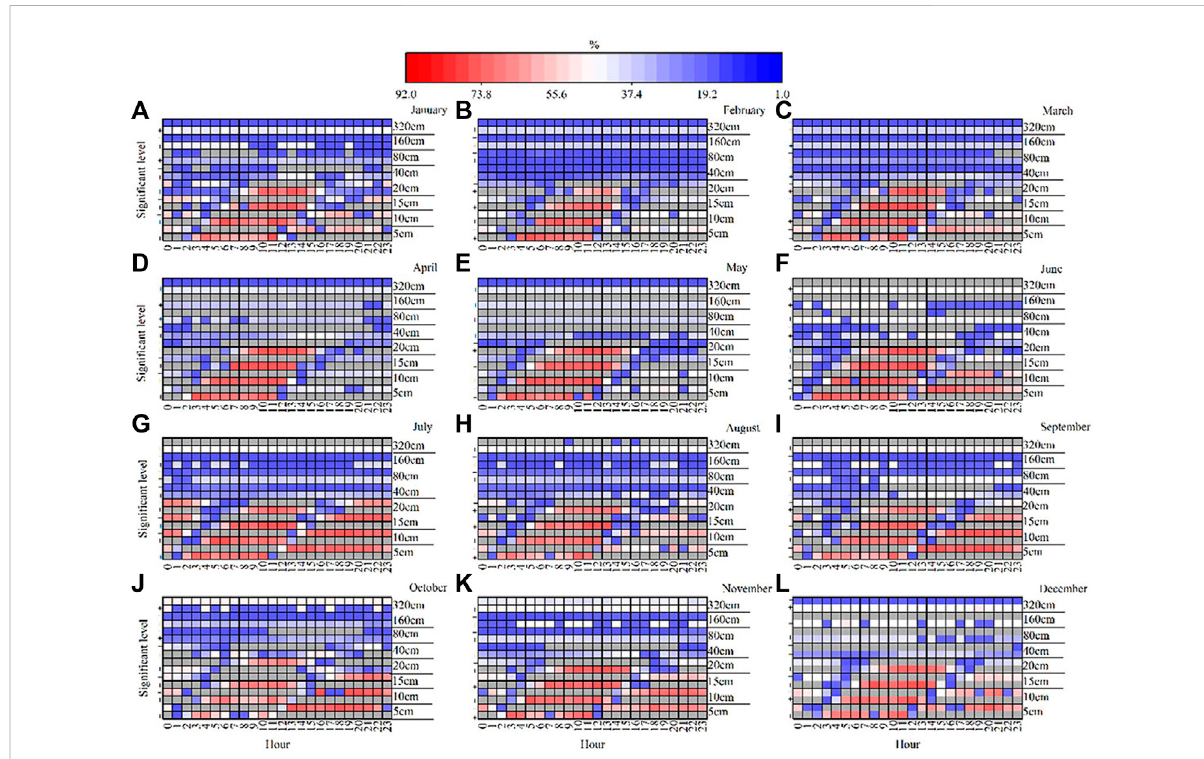
FIGURE 7 Station percentages of January (A) , February (B) , March (C) , April (D) , May (E) , June (F) , July (G) , August (H) , September (I) , October (J) , November (K) , December (L) soil temperature change trend at depths of 5 – 320 cm during 2004 – 2020 in Yunnan (plus sign indicates signi fi cant percentage increase, minus sign indicates signi fi cant percentage decrease, and gray shading indicates percentage without signi fi cant increase or